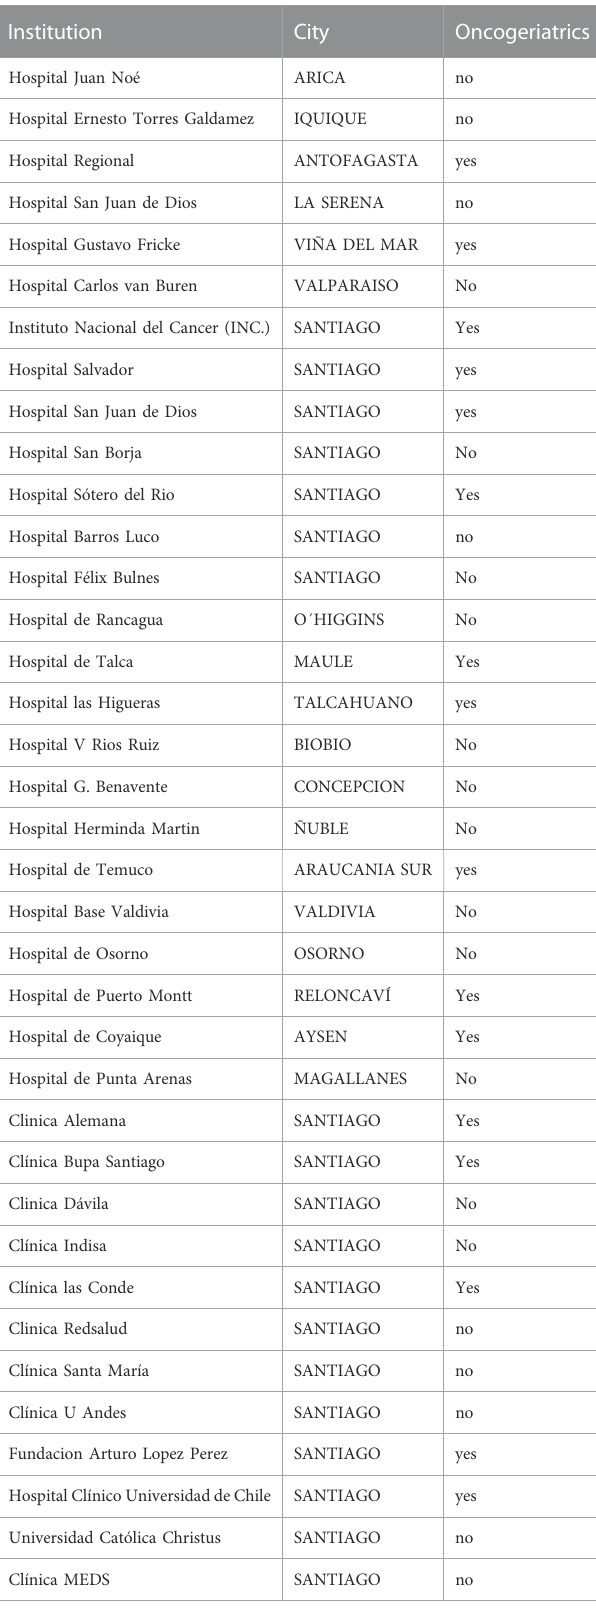
TABLE 3 Hospitals and private centers that provide Cancer treatment with or without oncogeriatric units in